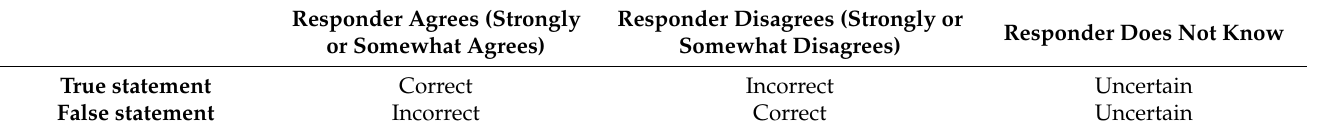
Table 1. Coding scheme of the 23 neuroliteracy statements.